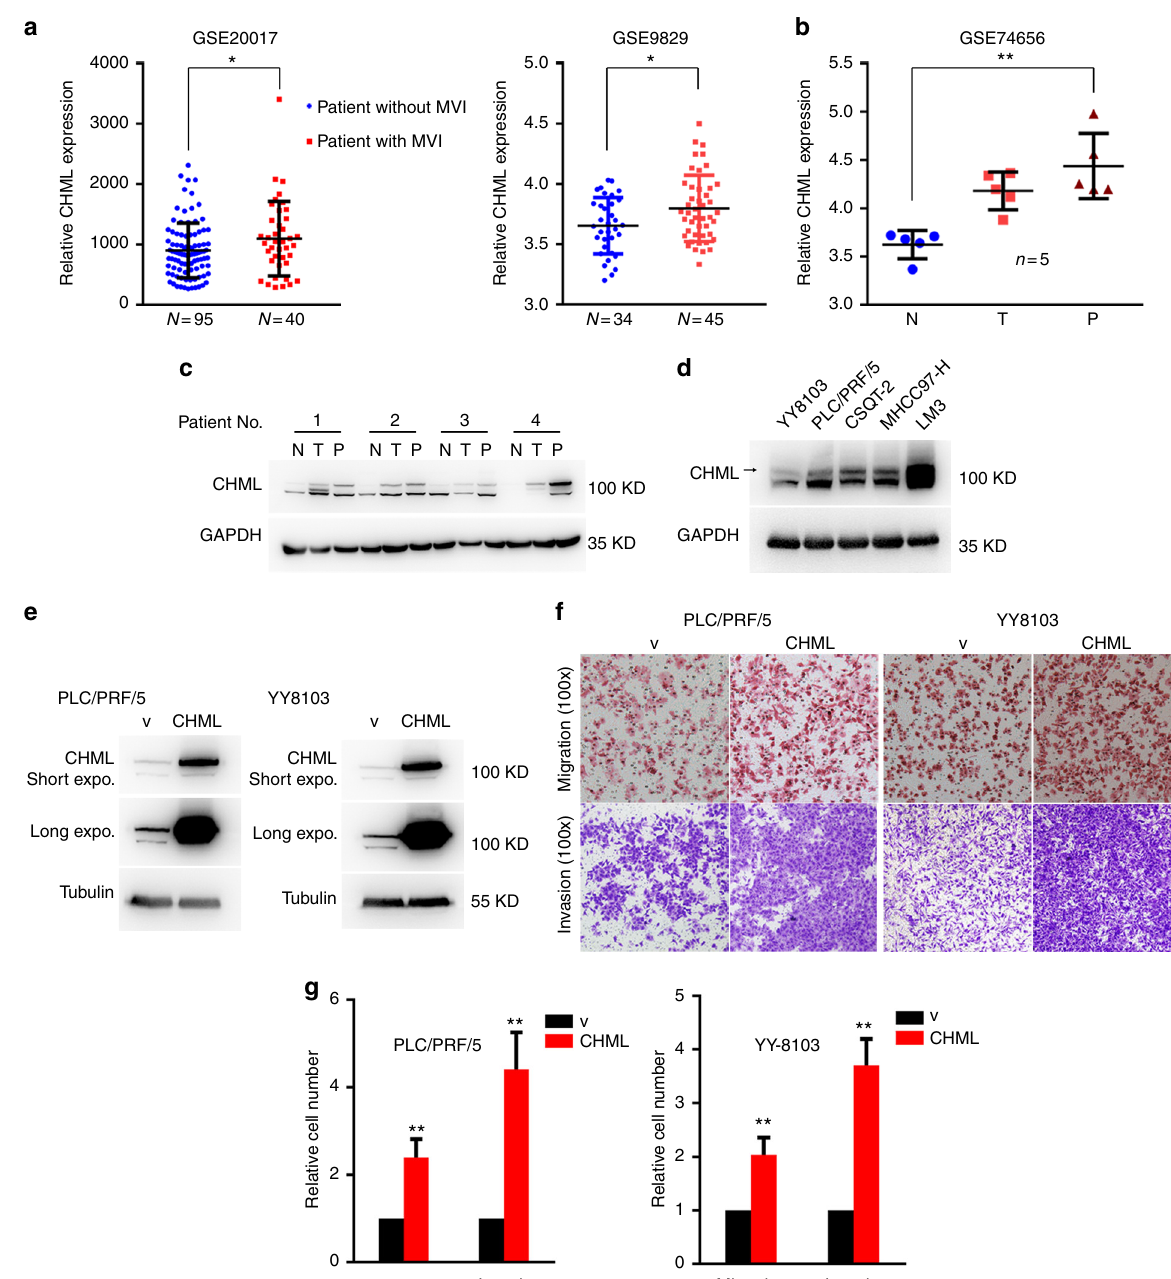
Fig. 2 CHML overexpression promotes HCC cell metastasis and invasion. a Dot plots comparing CHML expression in patients with or without microvascular invasion (MVI) in two published datasets. * P < 0.01, Student ’ s t -test. b Dot plot analysis of CHML expression in normal, HCC and portal vein tumor thrombus (PVTT) tissues. N normal, T tumor, P PVTT. ** P < 0.01 by two-tailed unpaired Student ’ s t -test. c Western blot analysis of CHML expression in normal, HCC, and PVTT tissues obtained from 4 patients. d Western blot analysis of CHML expression in 5 HCC cell lines. Arrow indicated the CHML band. e Western blot analysis of the overexpression ef fi ciency of CHML in HCC cell line PLC/PRF/5 and YY8103. v vector control. f Boyden chamber and invasion assay are conducted to detect the migratory and invasive ability of control cells and CHML-overexpressed cells. Each representative image is shown. g Quantitative results are respectively illustrated for panel ( b ). Data are shown as the mean ± s.e.m., ** P < 0.01 by two-tailed unpaired Student ’ s t -test. All data are represented as mean ± (Fig. 6c, d). GDP/GTP status of Rab14 was regulated by GDI, nucleotide binding status, we hypothesized GDP/GTP status of GAP and GEF, decreased amount of GDI and GAP could result Rab14 might be affected by CHML. To validate this hypothesis, in GTP accumulation (Fig. 6e). Thus CHML might function as a we puri fi ed GST- Δ RCP559-649 fusion protein, which was GDI or a GAP protein. Actually, GDI binds to GDP-loaded Rab reported to speci fi cally interact with GTP-Rab14 18 . GST pull- down assay using this substrate demonstrated that GTP-Rab14 while GAP binds to GTP-bound form. Based on this difference, was accumulated in CHML KD PLC/PRF/5 cells and YY8103 we fused Flag tag to Rab14WT, and two mutants, Rab14S25N cells (Supplementary Fig. 6a, b), as well as CSQT-2 and LM3 cells mimicking GDP-Rab14 and Rab14Q70L mimicking GTP-Rab14,